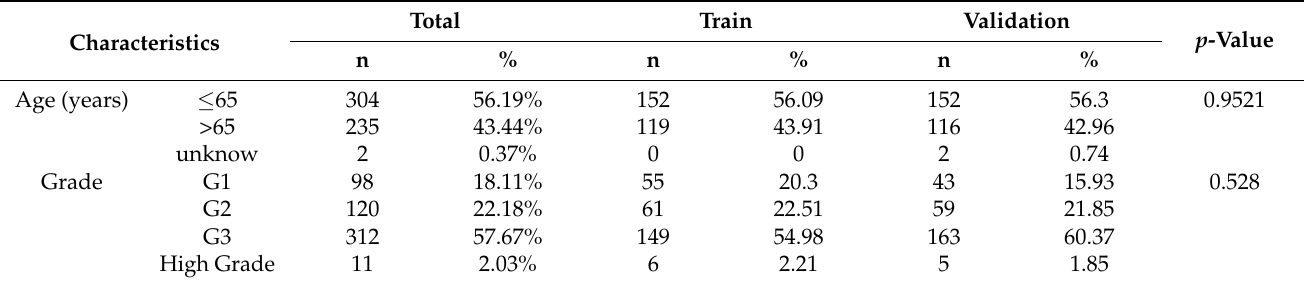
Table 1. Clinicopathological characteristics of patients with